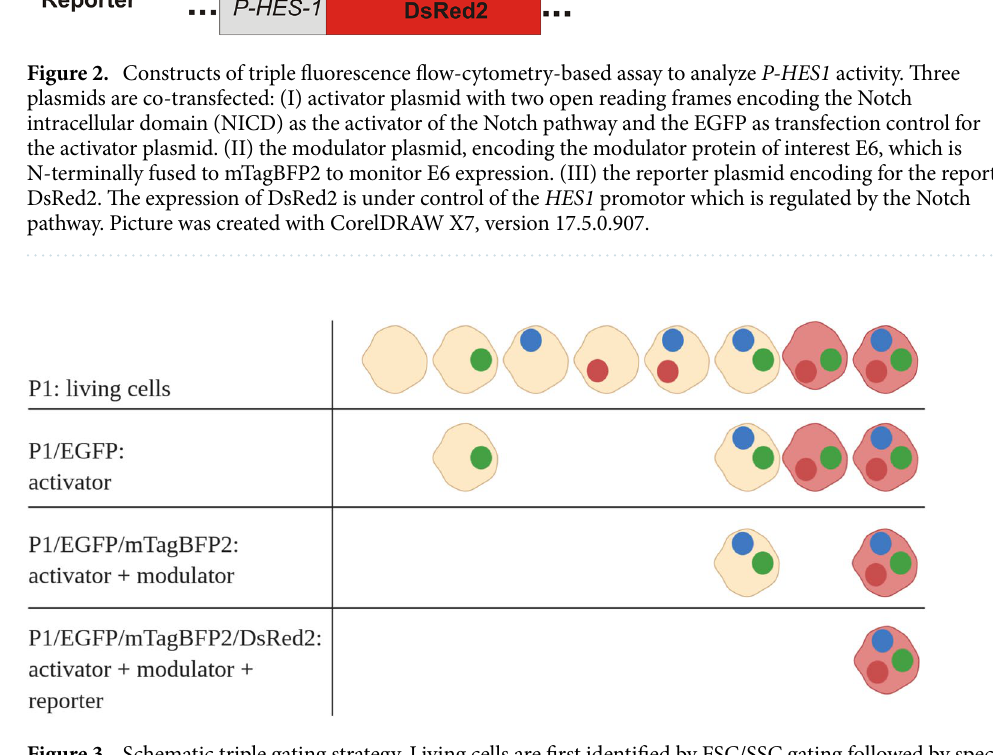
Figure 3. Schematic triple gating strategy. Living cells are first identified by FSC/SSC gating followed by specific inclusions of cells that are transfected with the activator plasmid (EGFP + cells). Next step is to gate on EGFP/ mTagBFP2 to only monitor cells that have been transfected with the activator and the modulator (EGFP + / mTagBFP2 + cells). Then, Notch-activation is assessed in this population by measuring the DsRed2 expression (EGFP + /mTagBFP2 + /DsRed2 + cells). Picture was created with